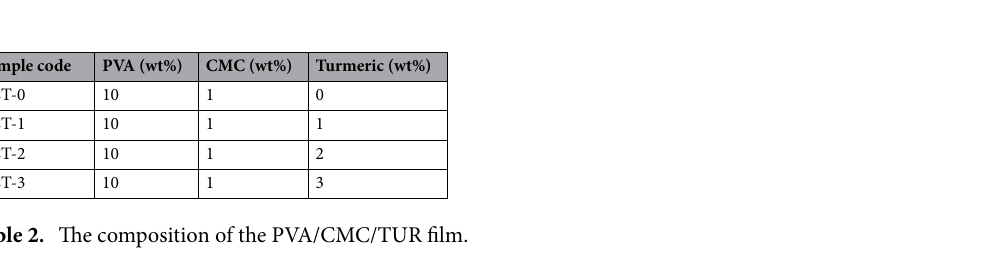
Table 2. The composition of the PVA/CMC/TUR film.